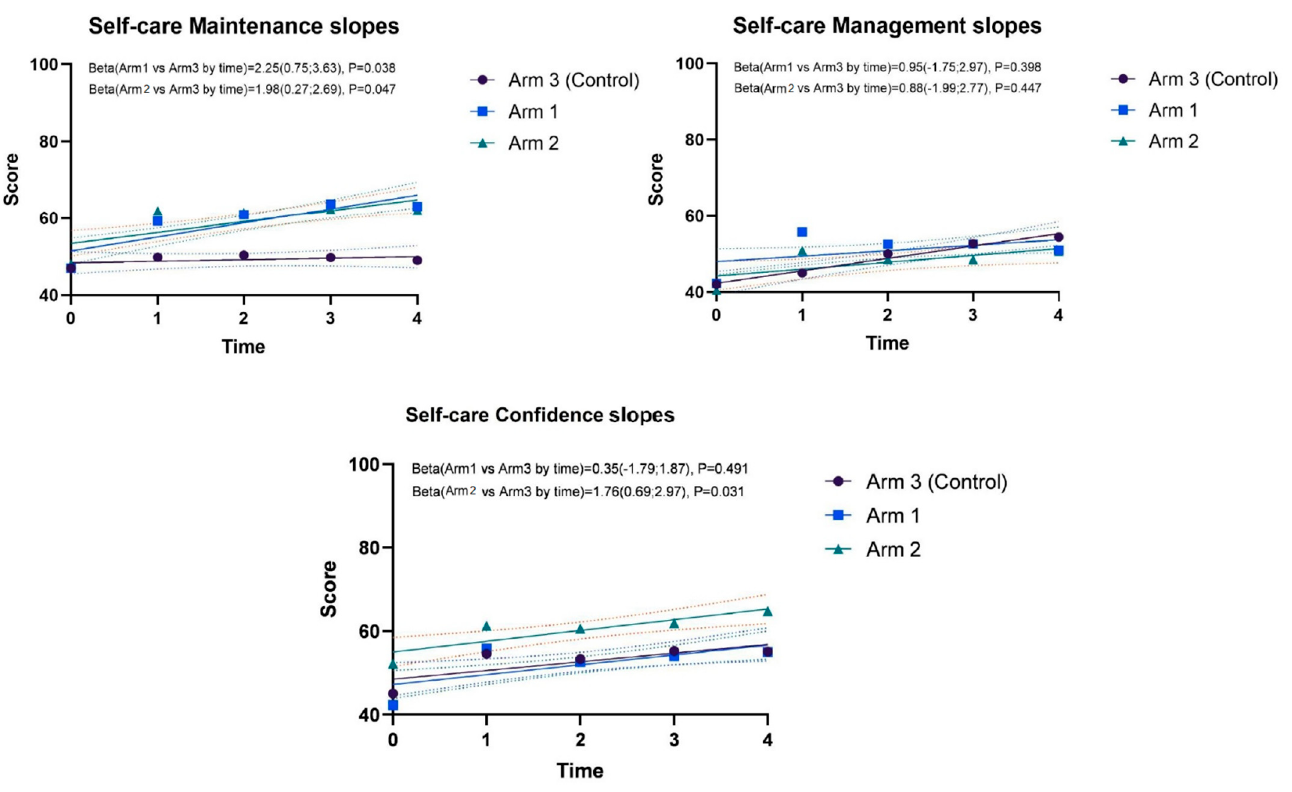
Figure 3. Model-based self-care maintenance, self-care management, and self-care confidence scores by follow-up times.